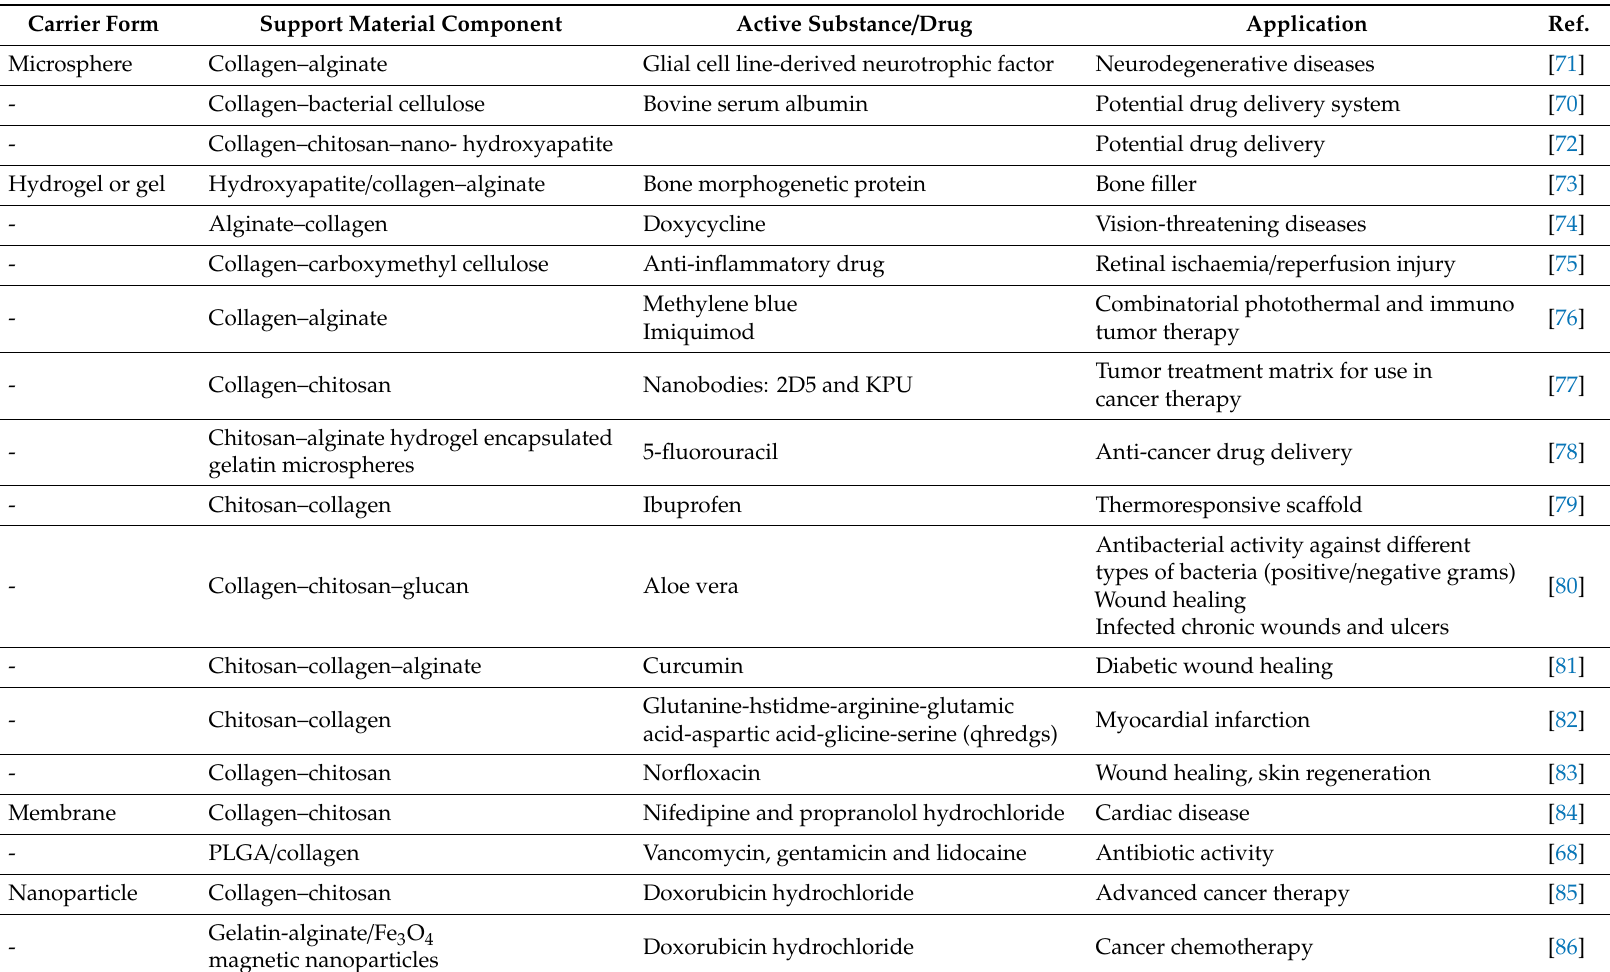
Table 2. Drug delivery systems based on blended